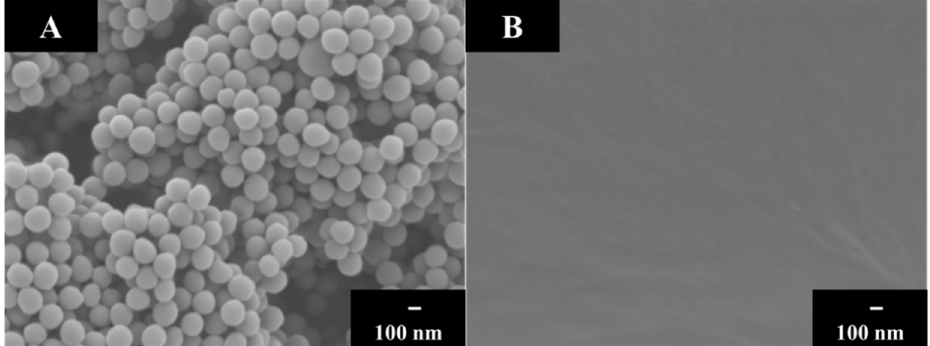
Figure 4. SEM images of ( A ) as-deposited and ( B ) annealed PVDF films fabricated via EPD from 5 g L − 1 PVDF suspension containing 1 g L − 1 GA as a dispersant. The films were obtained at deposition time of 5 min and deposition voltage of 100 V.